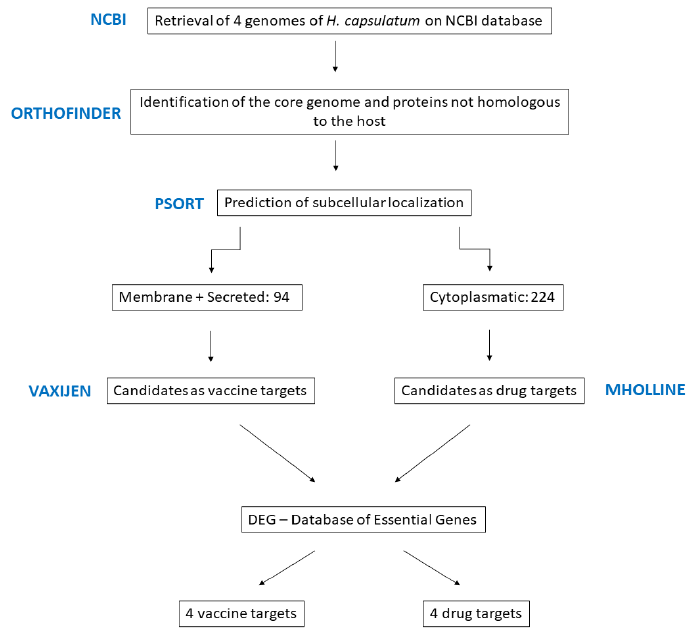
Figure 1. Workflow of methodologies used to select the drug and vaccine candidates. The bioinfor- matic tools and the total number of proteins are identified at each step.